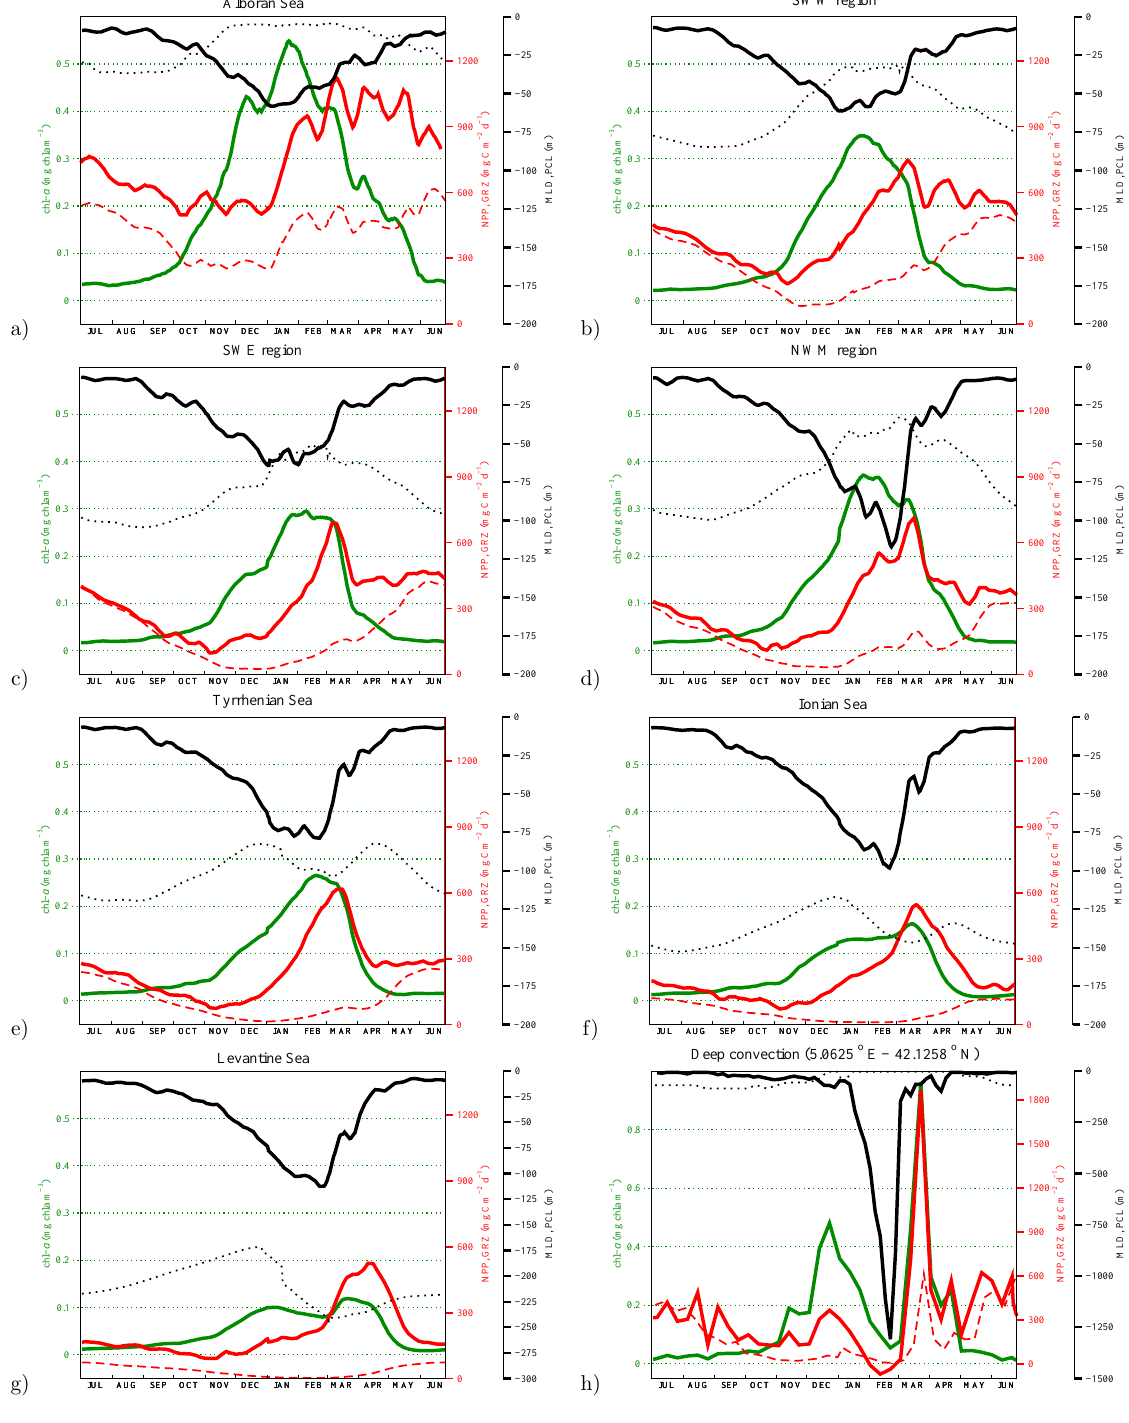
Fig. 11. Longhurst diagrams for the regions considered in the model (a, b, c, d, e, f, g) and the deep convection area (h) . Red solid lines represent int-NPP (mgCm − 2 d − 1 ) and dashed red lines represent grazing of phytoplankton (mgCm − 2 d − 1 ), green solid lines represent surface chlorophyll (mgchl- a m − 3 ), black solid lines represent mixed layer depth (m) and black dotted lines represent the depth of the 0.05 mmol P m − 3 isophosphate (m). Note the different scale for MLD in panel (g) and (h) and for NPP in panel (h)